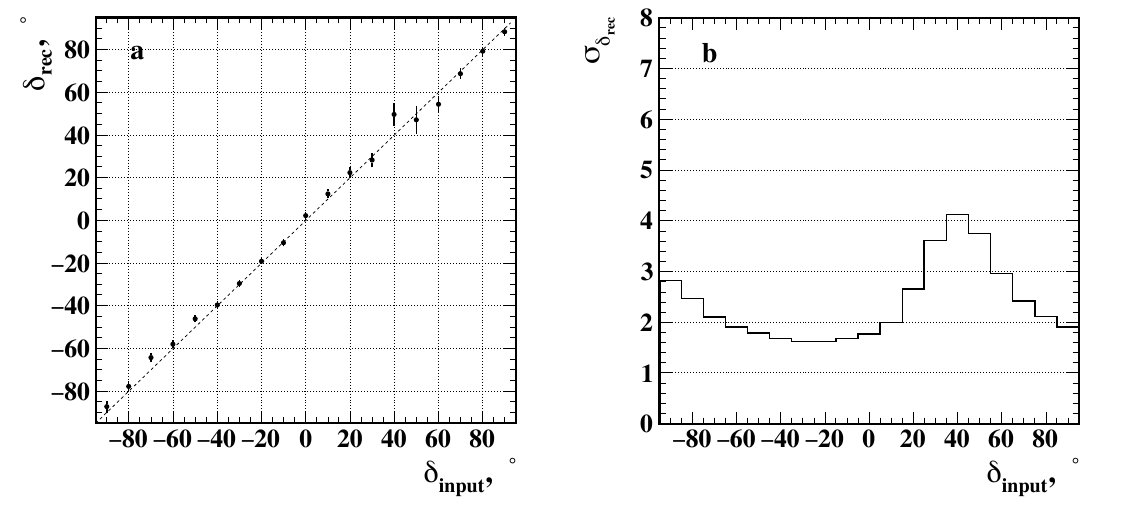
Figure 7 . (a) Resulting (cid:14) values extracted from the (cid:12)t with the obtained uncertainty (b).